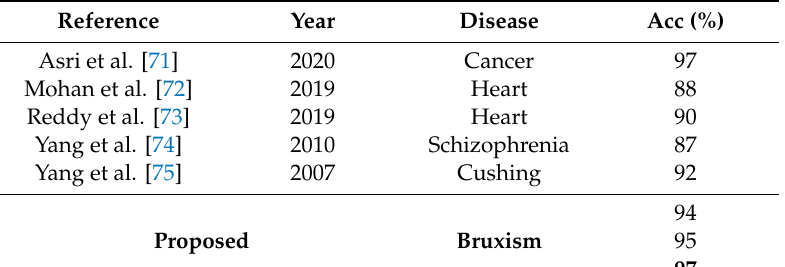
Figure 10. A comparison of the ( A ) proposed method with the existing methods and ( B ) proposed HML classifier with the existing hybrid classifiers. Table 6. Comparison of the proposed HML classifier with the existing hybrid Table 5. Comparison of the proposed method with the existing methods.